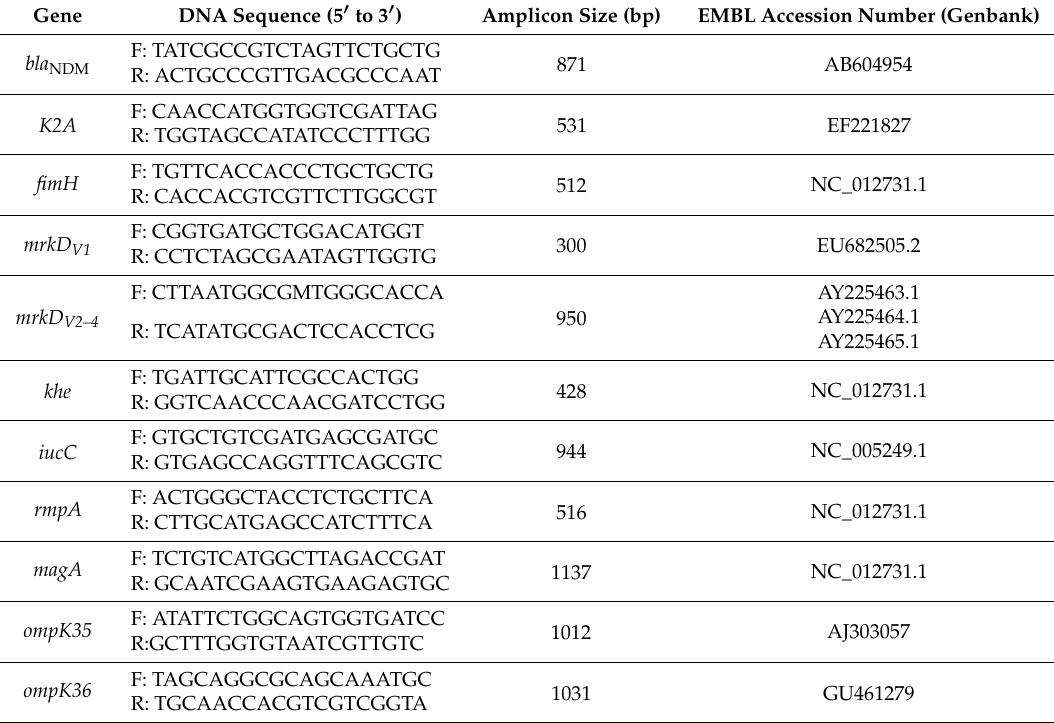
Table 3. List of primer designs in the current study and expected amplicon